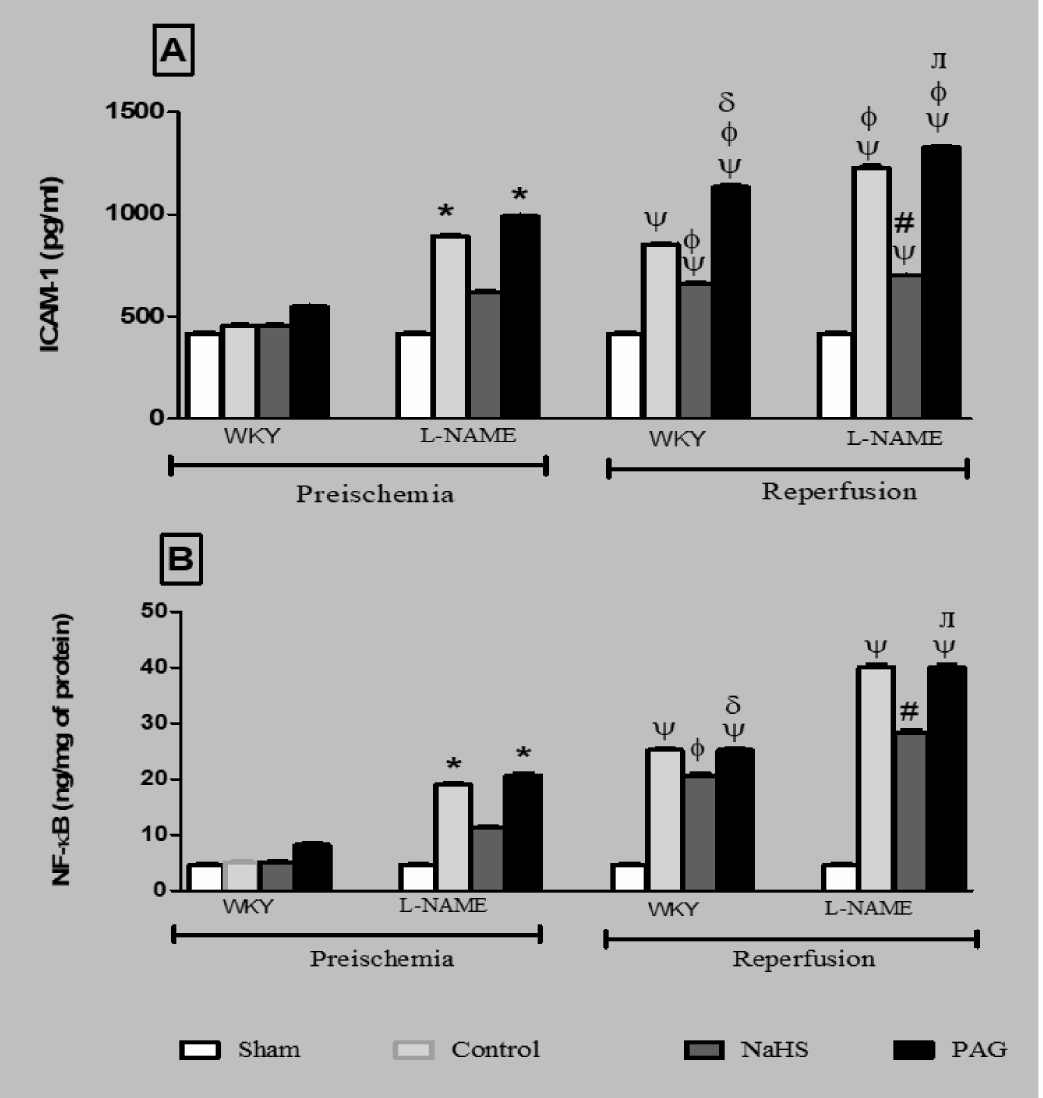
Figure 6. ( A ) ICAM-1 concentration and ( B ) NF-kB concentration in kidney tissues of different experimental groups of WKY and L-NAME rats before and after ischemia ( n = 6). Data were analysed using one-way ANOVA followed by Bonferroni’s post hoc test. Ψ p < 0.05 vs. pre-ischemic phase of respective groups; * p < 0.05 vs. WKY-CONTROL at pre-ischemic phase; φ p < 0.05 vs. WKY-CONTROL at reperfusion phase; δ p < 0.05 vs. WKY+NaHS at reperfusion phase; # p < 0.05 vs. L-NAME-CONTROL at reperfusion phase; л p < 0.05 vs. L-NAME+NaHS at reperfusion phase. ICAM- 1 = intercellular adhesion molecule-1; NF-kB = nuclear factor-kappa B; PAG = dL-propargylglycine; WKY = Wistar Kyoto rats; L-NAME =